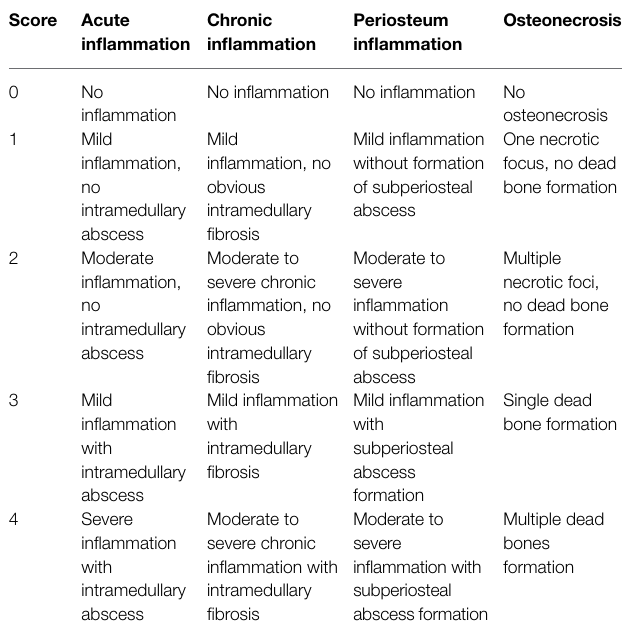
TABLE 1 | Norden osteomyelitis score.